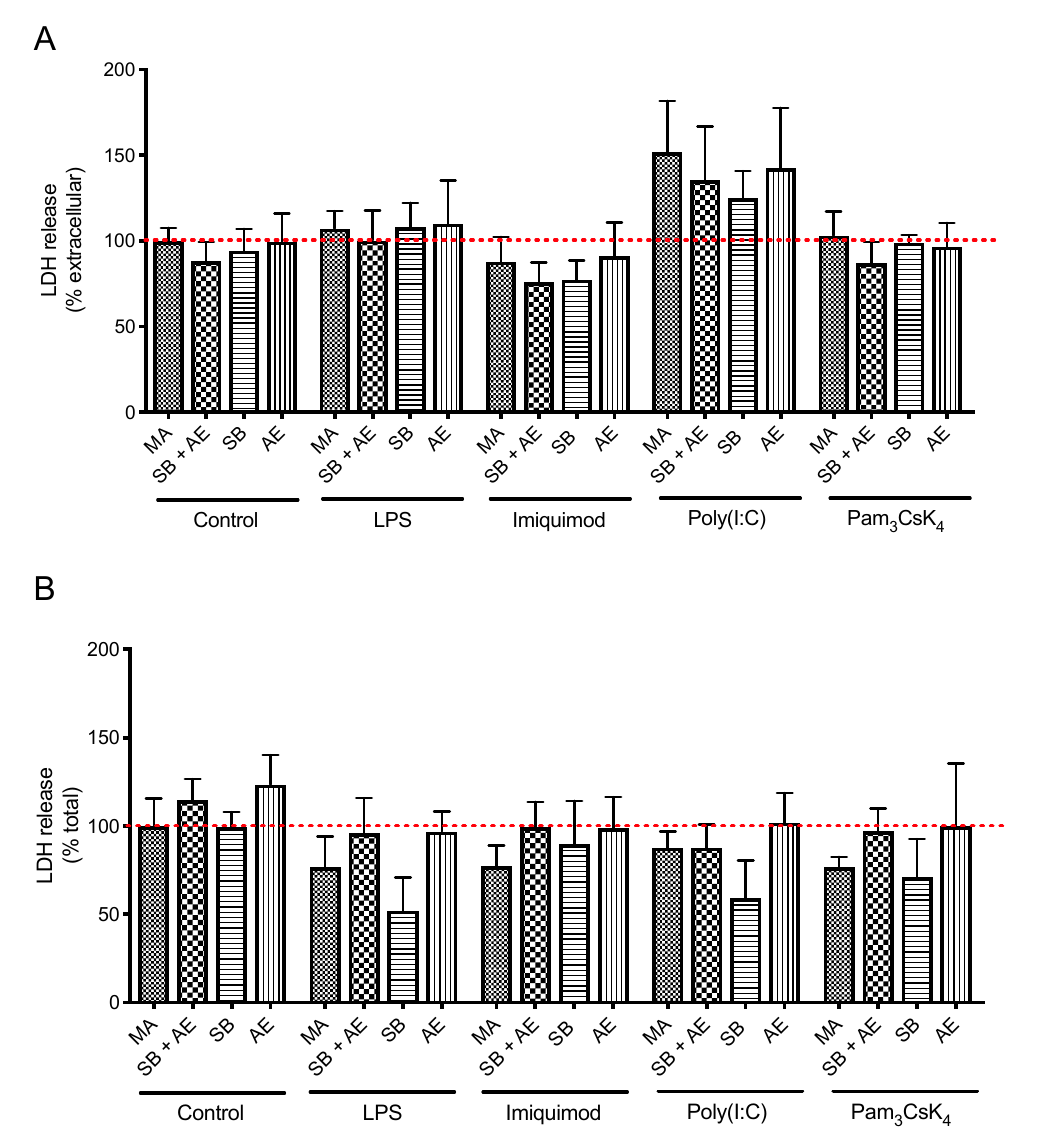
Figure 3. LDH extracellular ( A ) and total ( B ) quantification of RAW 264.7 cells cultured over the Ti-discs with different surfaces: mechanical abrasion (MA), sandblasting plus etching (SB + AE), sandblasting (SB) and acid etching (AE) and with or without the TLR ligands LPS (TLR4), imiquimod (TLR7), poly(I:C) (TLR3) and Pam3Csk4 (TLR2/1) (n = 6).